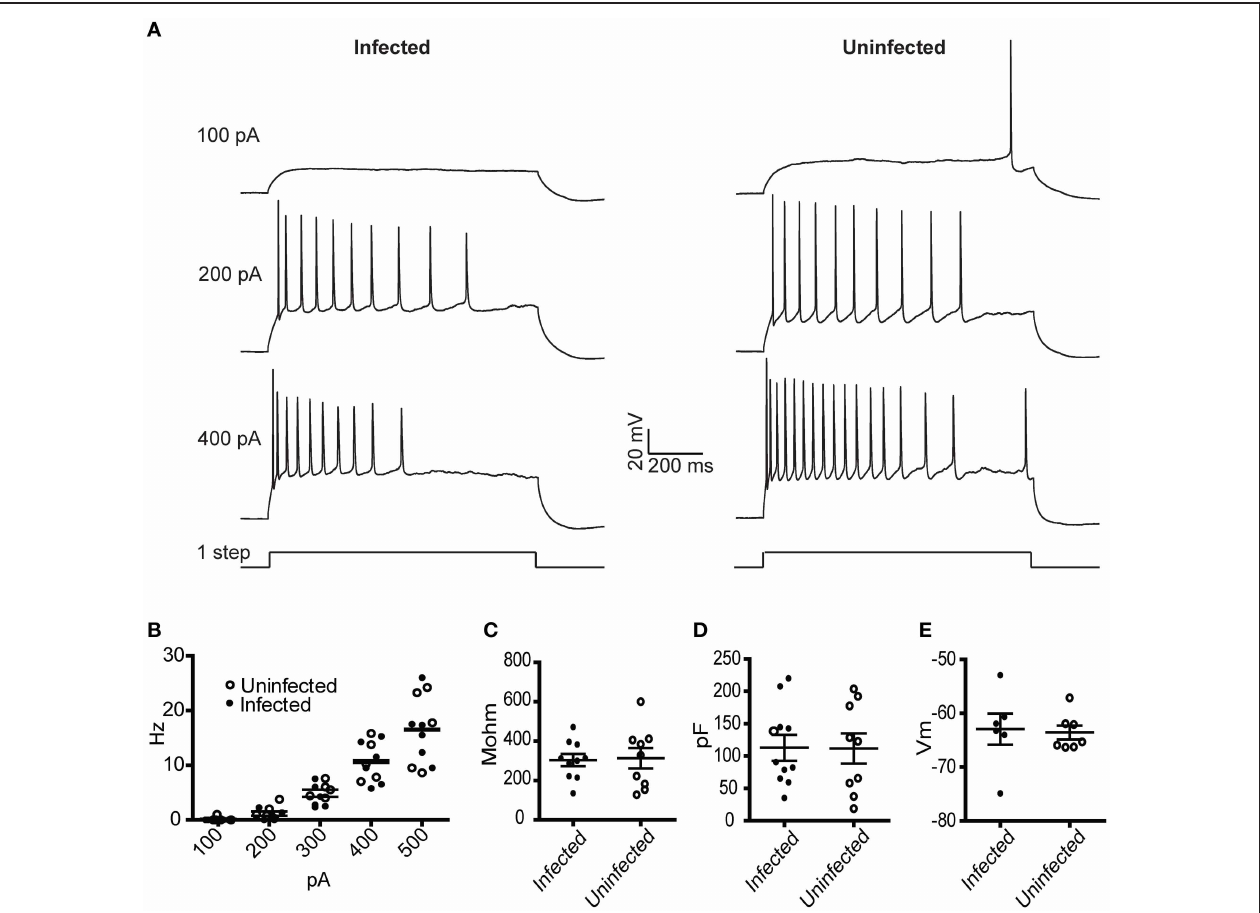
potential firing frequency relationships are unaffected by infection (infected cells, N = 7; uninfected cells, N = 6). Horizontal bars denote averages. Infection does not alter the (C) input resistance, the (D) capacitance, or (E) resting membrane voltages (infected cells, N = 10, uninfected cells, N = 9). Horizontal bars denote mean with standard error of the